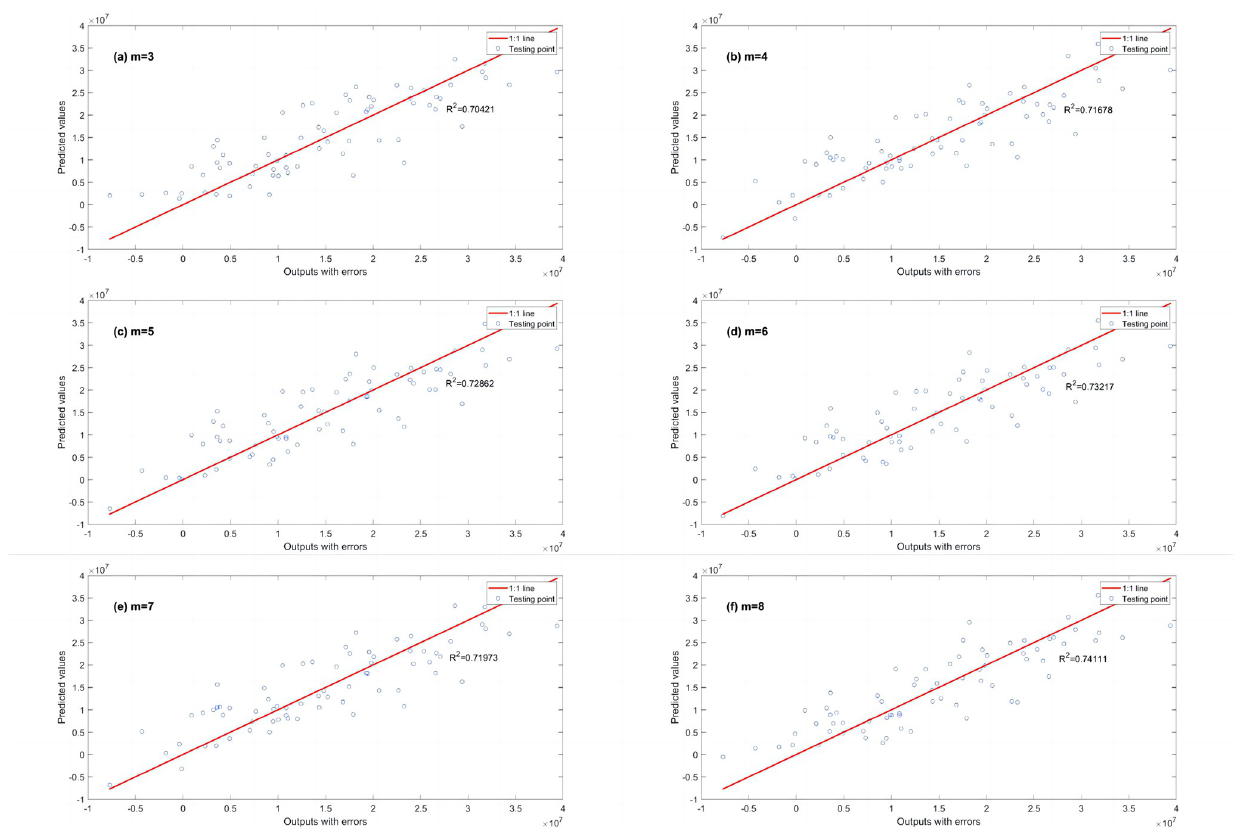
Fig 16. R 2 calculated by EPR with PCS in dataset 4. (a) m = 3, (b) m = 4, (c) m = 5, (d) m = 6, (e) m = 7 and (f) m =